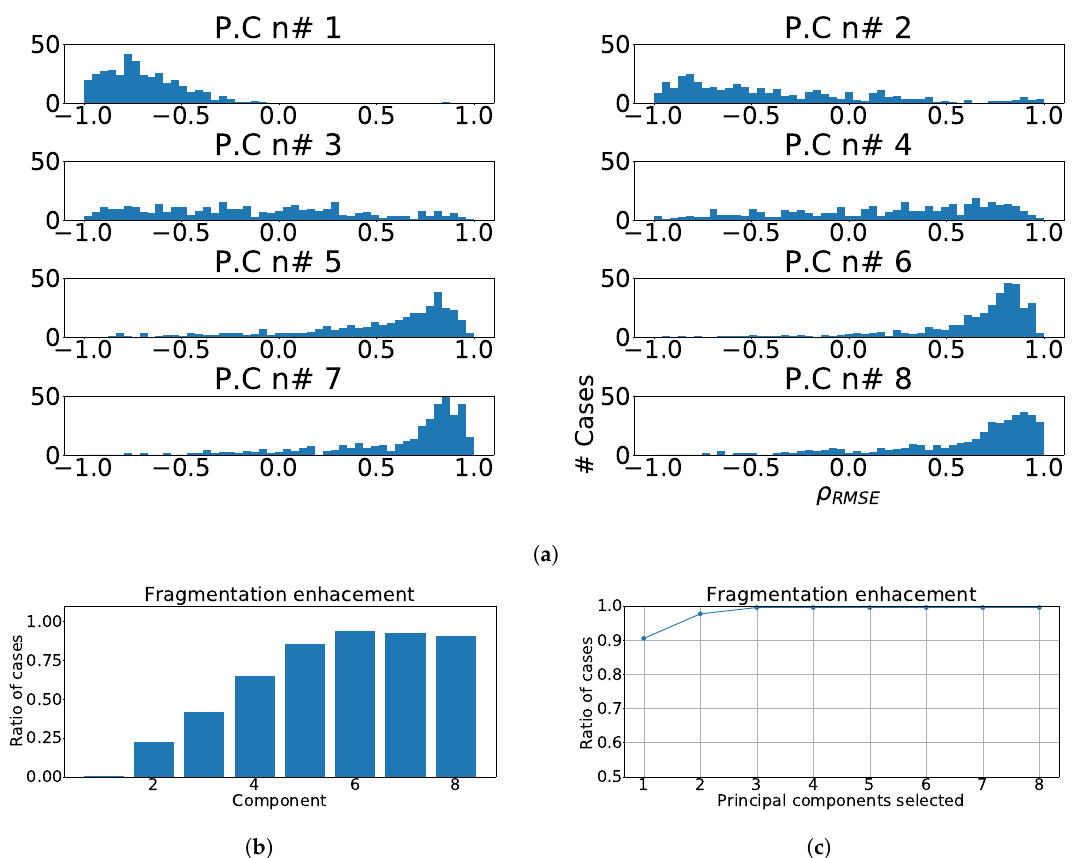
Figure 4. Measurements of fragmentation enhancement using PCA over independent leads. ( a ) Distribution of ρ RMSE coefficient for each component, values higher than 0 represent fragmented wave enhancement. ( b ) Enhancement ratio for each component. ( c ) Joint enhancement